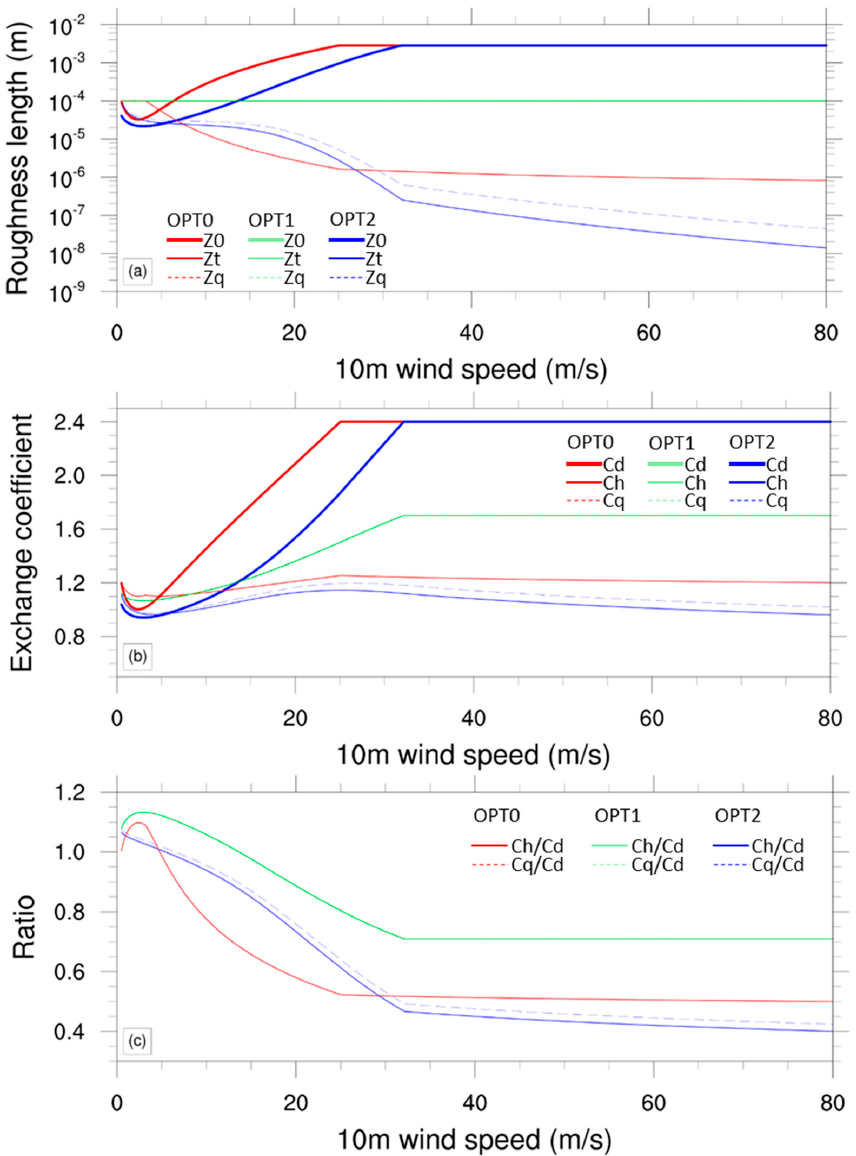
Figure 2. Plots as functions of 10 m wind speed of ( a ) roughness lengths 𝑧 (cid:2868) (thick solid), 𝑧 (cid:3047) (thin solid), and 𝑧 (cid:3044) (dashed); ( b ) exchange coefficients 𝐶 (cid:3031) (thick solid), 𝐶 (cid:3035) (thin solid), and 𝐶 (cid:3044) (dashed); ( c ) exchange coefficient ratios 𝐶 (cid:3035) /𝐶 (cid:3031) (thin solid) and 𝐶 (cid:3044) /𝐶 (cid:3031) (dashed), for neutral stability condition. Air − sea flux schemes option 0, option 1, and option 2, colored red, green, and blue, re- spectively. As stated in the text, some curves are identical: for option 0, 𝑧 (cid:3047) = 𝑧 (cid:3044) and 𝐶 (cid:3035) = 𝐶 (cid:3044) ; for option 1, 𝑧 (cid:3047) = 𝑧 (cid:3044) and 𝐶 (cid:3035) = 𝐶 (cid:3044) ; and between option 1 and option 2, 𝑧 (cid:2868) (and thus 𝐶 (cid:3031) ) is the same. Figure 2 compared the theoretical results of the roughness length and surface ex- change coefficient from 3 surface flux parameterization schemes in the WRF version 4.0 model. For the roughness length in Figure 2a, specifically for the momentum roughness length 𝑧 (cid:2868) (thick solid line), OPT1 is the same as OPT2, and all of three have the same upper limit; for the thermal roughness length 𝑧 (cid:3047) (thin solid line) and the vapor roughness length 𝑧 (cid:3044) (dashed line), OPT1 is greater than OPT0 and OPT2. The surface exchange co- efficient is calculated from the roughness length, and for the surface exchange coefficient